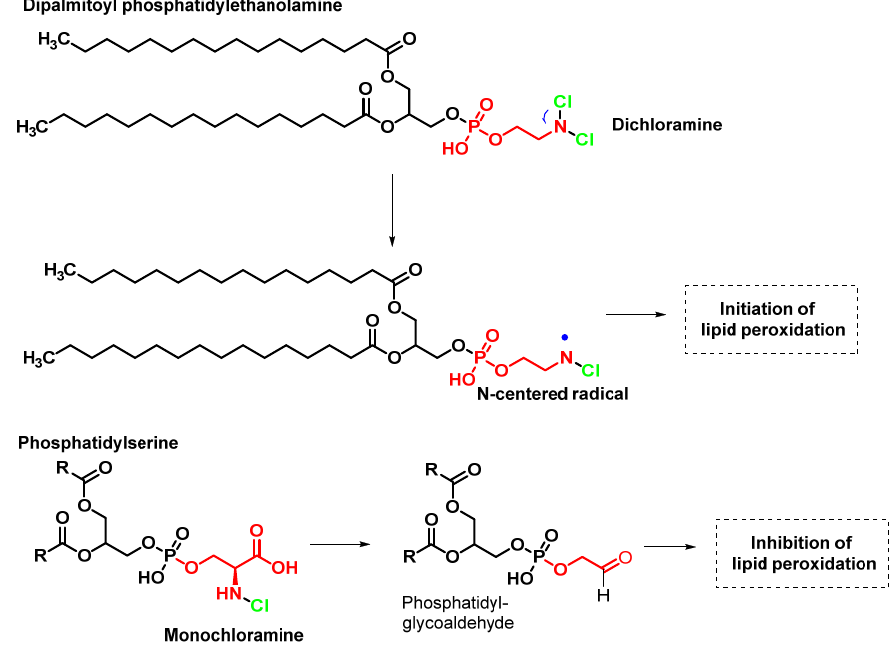
Figure 17. Conversion of the amino group of phosphatidylethanolamine and phosphatidylserine by reaction with HOCl.